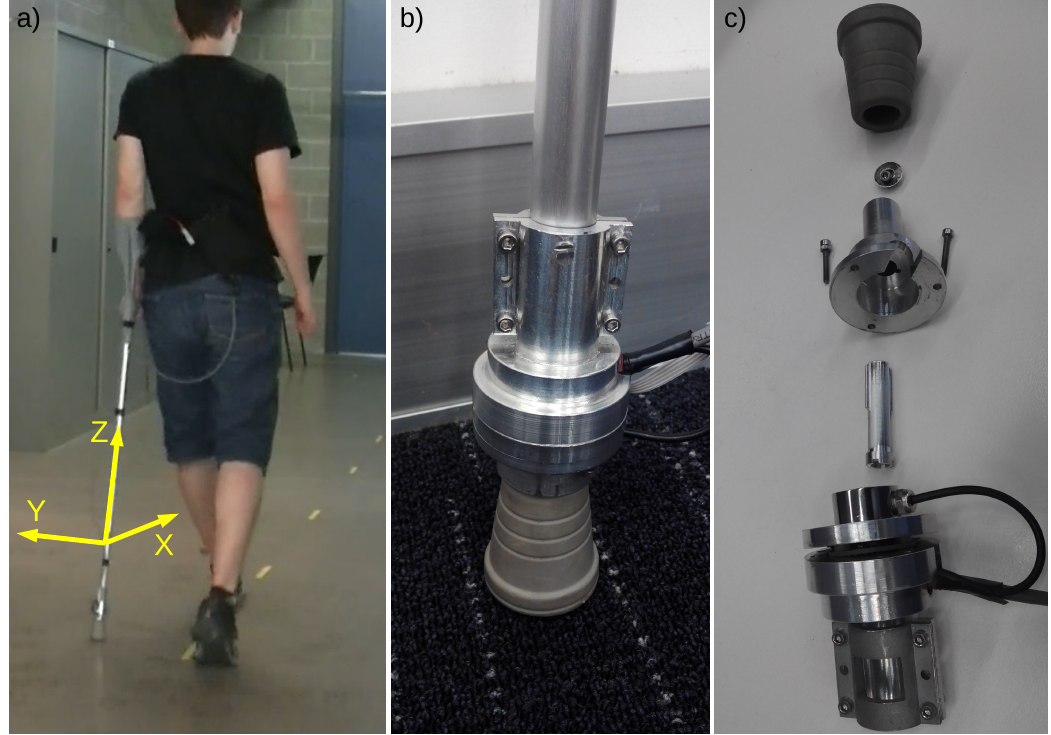
Figure 1. ( a ) A person using the instrumented crutch; ( b ) Assembled prototype tip; ( c ) Assembling the